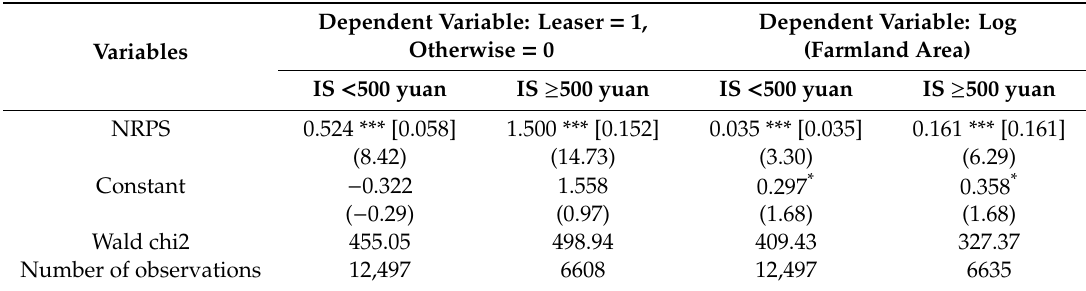
Table 9. Heterogeneity test of the insured standards (IS) of the